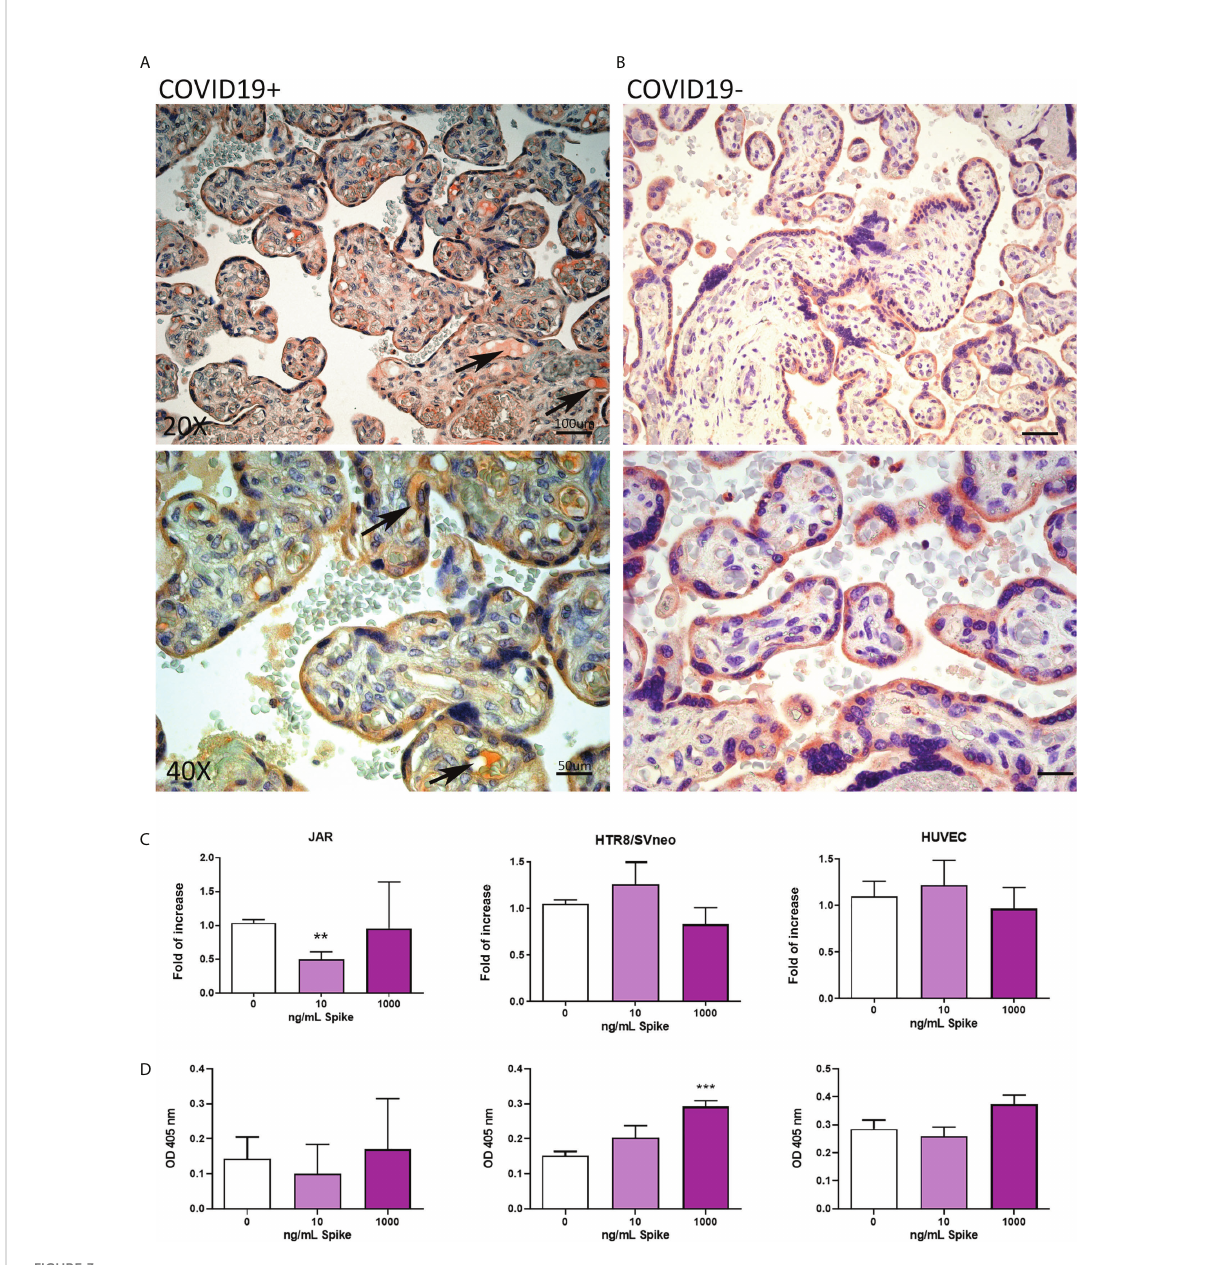
FIGURE 3 (A,B) RepresentativemicrophotographsshowingexpressionofACE2inCOVID-19+ (A) orCOVID-19- (B) placentaltissues.Arrowsshowthepresenceof ACE2positivityinfetalvesselsofchorionicvilli.Streptavidin – biotin – peroxidasecomplexsystemwithAEC(red)chromogen. (C) Afterstimulationwith10ng/ mLor1000ng/mLofSpikeS1proteinfor24h,RNAwasextractedfromplacentalcelllinesandquanti fi edfor ACE2 expressionbyRT-qPCR.Theexpression wasnormalizedusingthehousekeepinggenes 18S,ACTB and GAPDH ;resultsweremediated(geometricmean)andexpressedas foldofincrease .Dataare expressedasmean±SEofthreeindependentexperimentsperformedintriplicate.**p<0.01,ascomparedtountreatedcells(Mann-Whitneytest). (D) ELISAonwholecellsfordetectingACE2cellsurfaceexpressionafter24hofincubationwith10ng/mLor1000ng/mLofSpikeS1protein.Dataare